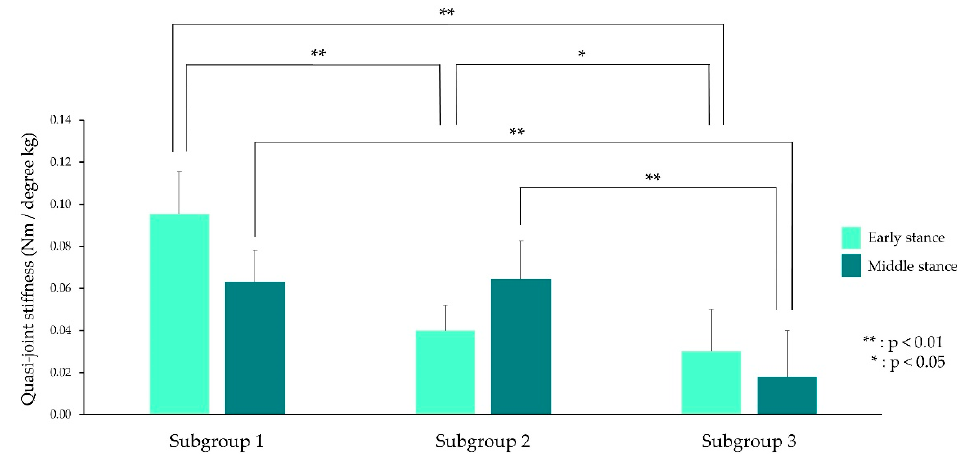
Figure 3. Quasi-joint stiffness in the early and middle stances in the three subgroups. Quasi-joint stiffness on the y -axis and individual subgroups on the x -axis. The light and dark green bars represents quasi-joint stiffness in the early and middle stances, respectively.